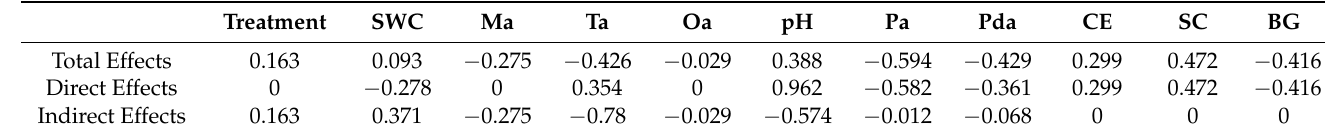
Table 2. The total, direct, and indirect effects of different indicators on soil organic carbon (SOC) in the structural equation model of different